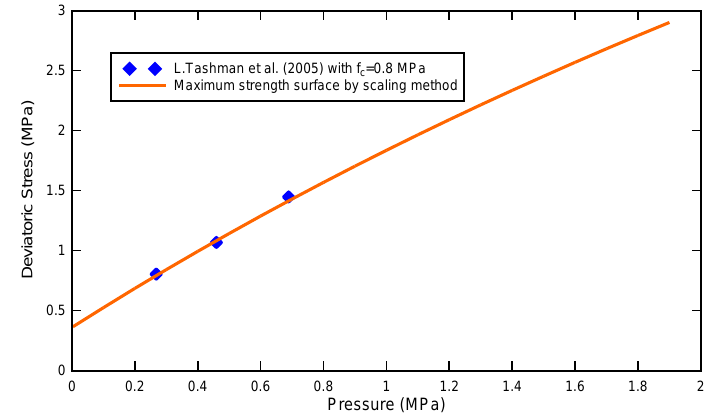
Figure 3. Validation of the failure surface from the scaling law. Table 1. Parameters for asphalt concrete (AC) material with f c = 4.6 MPa.